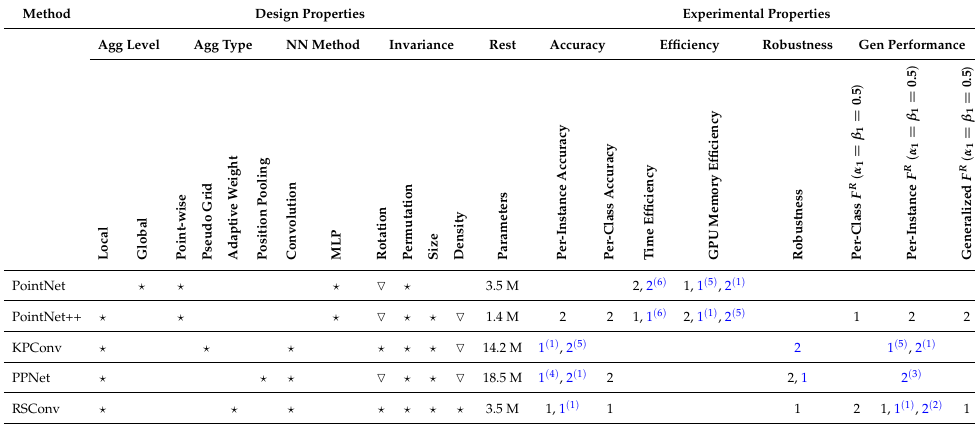
Table 9. Model comparisons according to their design and experimental properties. In Rotation, Size, and Density, the (cid:63) and (cid:79) and denote strong or weak invariance to such transformations respectively. In the Experimental Properties, the ranking numbers in black color refer to the results using the ShapeNet-part dataset, while the numbers in blue color refer to the results of the S3DIS dataset. Please note that the up-script number (#) in the blue ranking format ( number ( # ) ) denotes the number of Areas, where the model achieved either 1st or 2nd